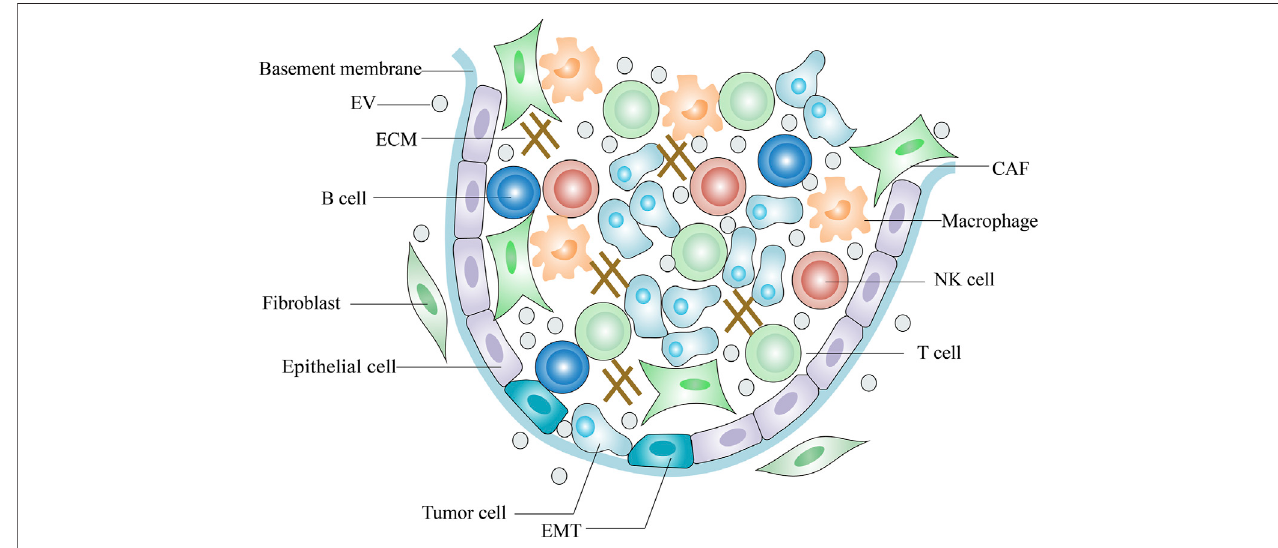
FIGURE 1 | Scheme of tumor